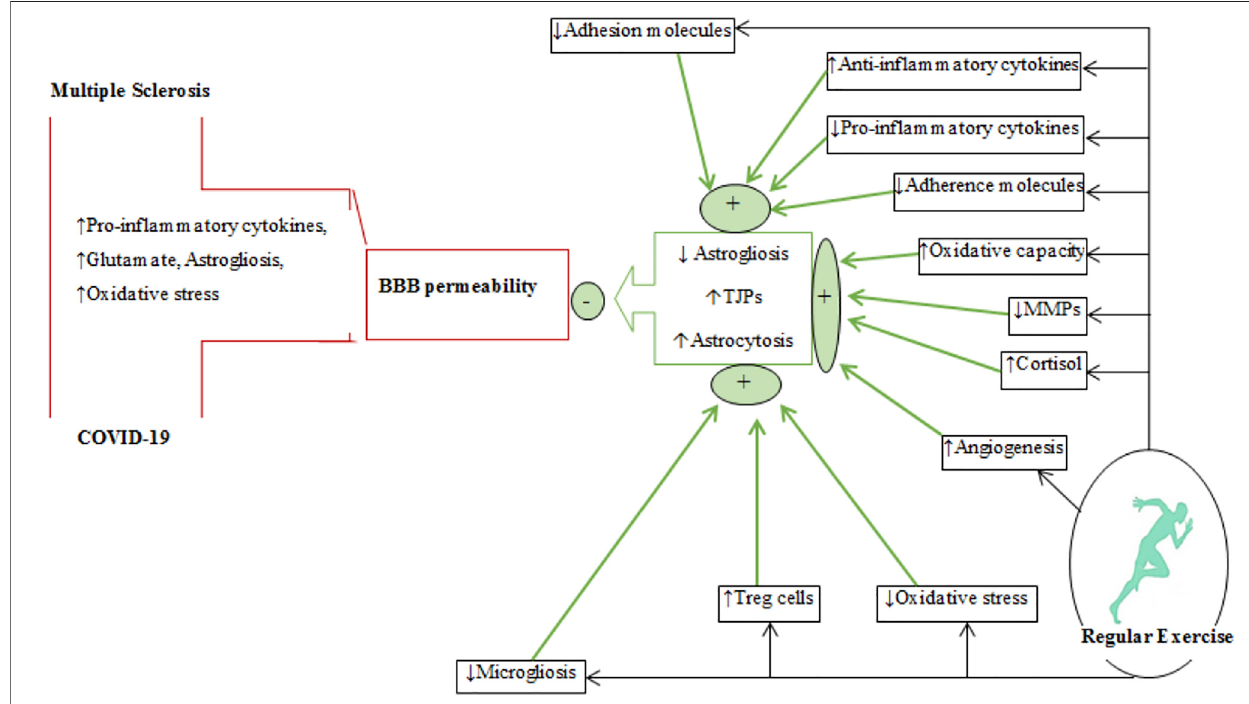
FIGURE 5 | A schematic diagram depicting the effects regular exercise on BBB permeability in multiple sclerosis and COVID-19. The plus (+) and minus ( − ) signs represent increases and decreases, respectively. The effects of regular exercise are shown by thick green arrows. MMPs, matrix metalloproteinases; Treg, T regulatory cells; TJPs, tight-junction proteins; BBB, blood-brain